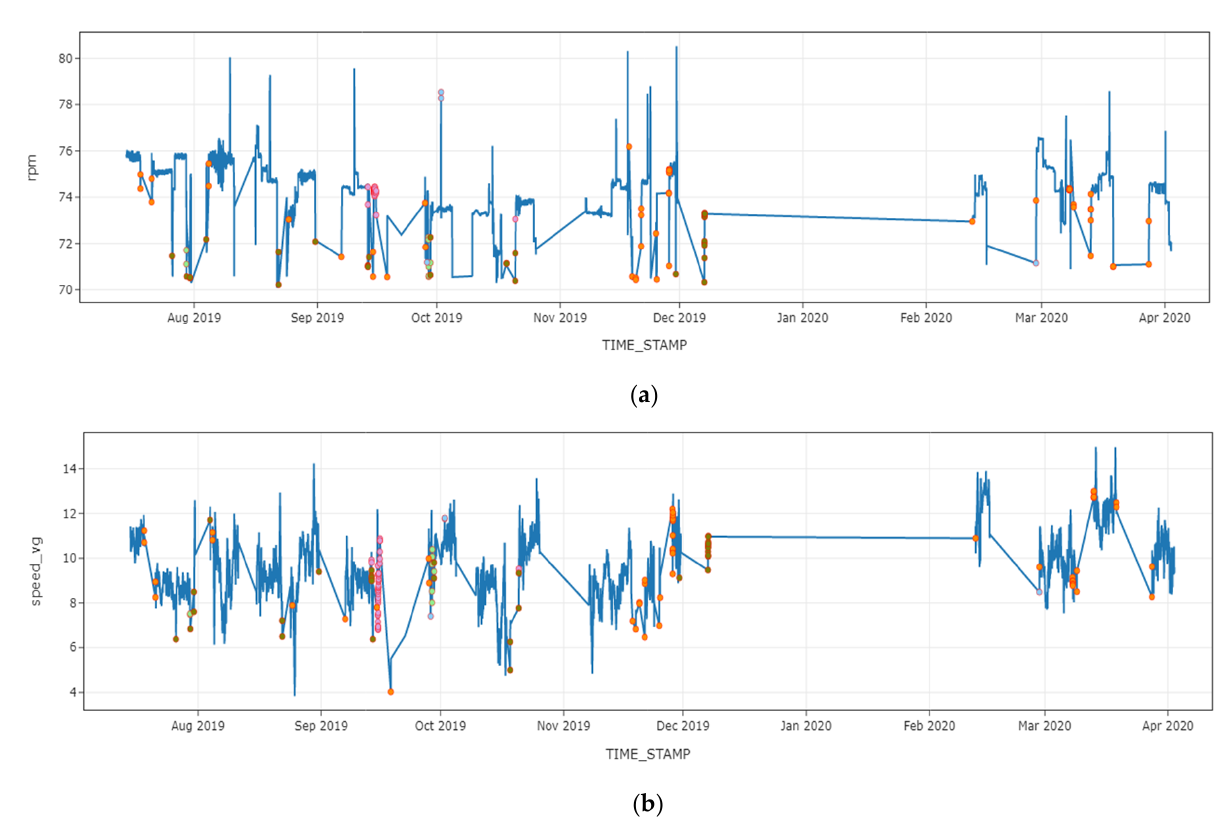
Figure 18. Anomalies plotted over the ( a ) rotation per minute and ( b ) speed over the ground of the vessel.